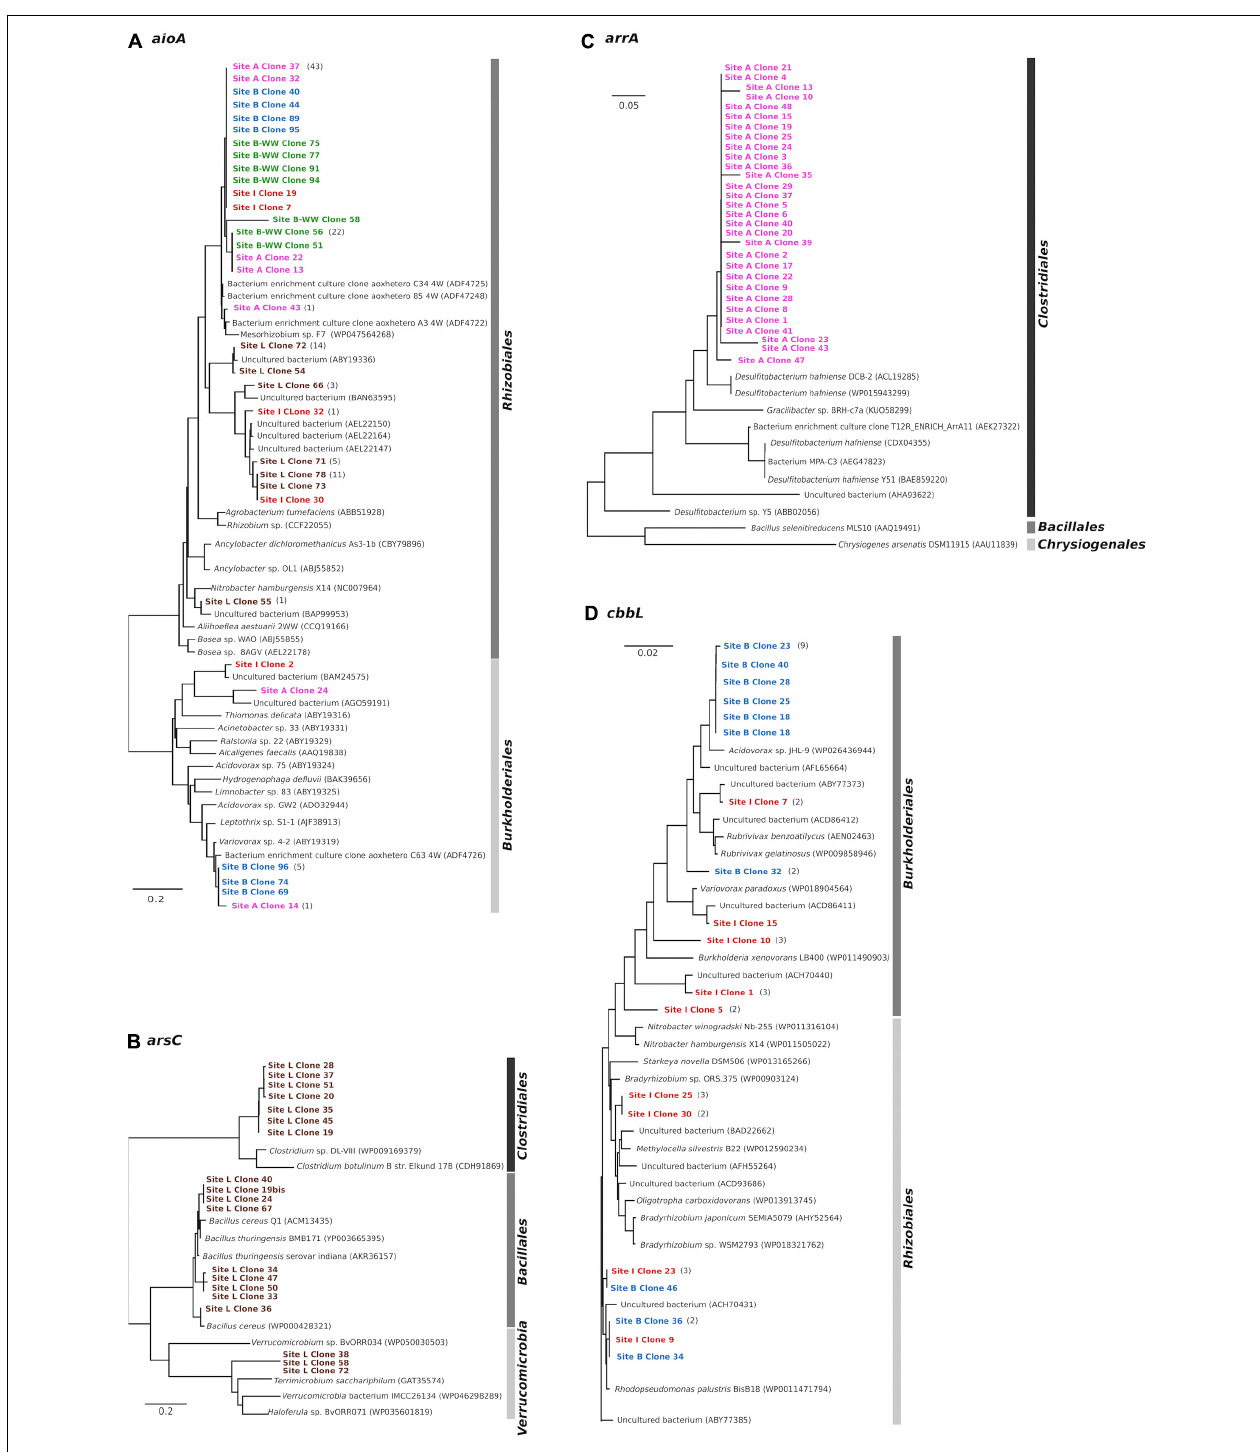
FIGURE 3 | Phylogenetic analysis (neighbor-joining tree) of deduced amino acid sequences of aioA (A) , arsC (B) , arrA (C) and type I RuBisCO cbbL (D) genes cloned from arsenic-contaminated aquifers and sequences from the NCBI database. As outgroup for the calculations, the AioA sequence of Hoeflea phototrophica DFL-43, the ArsC sequence of Achromobacter xylosoxidans A8, the ArrA sequence of Shewanella sp. ANA-3 and the CbbL sequence of Ancylobacter dichloromethanicus As3-1b were used. The scale bar represents a difference of 0.2 nucleotides per position for AioA and ArsC, of 0.05 for ArrA, and of 0.02 nucleotides per position for